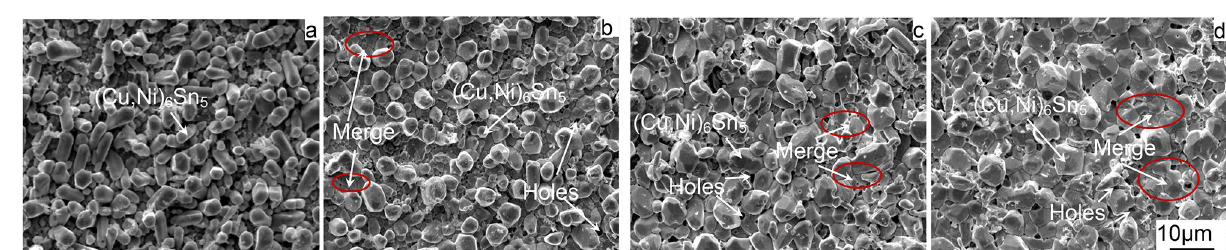
Figure 7. Top-view of IMC of Sn2.5Ag0.7Cu0.1RExNi/Cu solder joints after 0, 300, 700, 1000 thermal cycles. ( a ) 0 cycle, ( b ) 300 cycles, ( c ) 700 cycles, ( d )